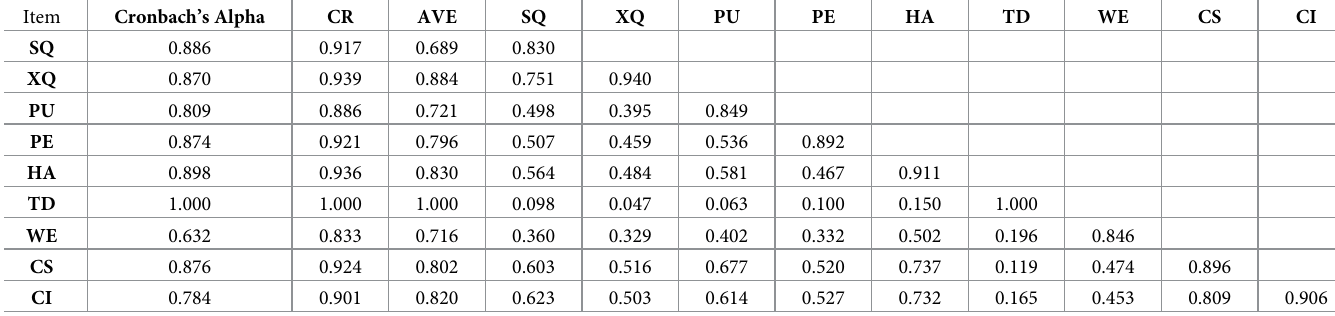
Table 3. Descriptive statistics and inter-construct